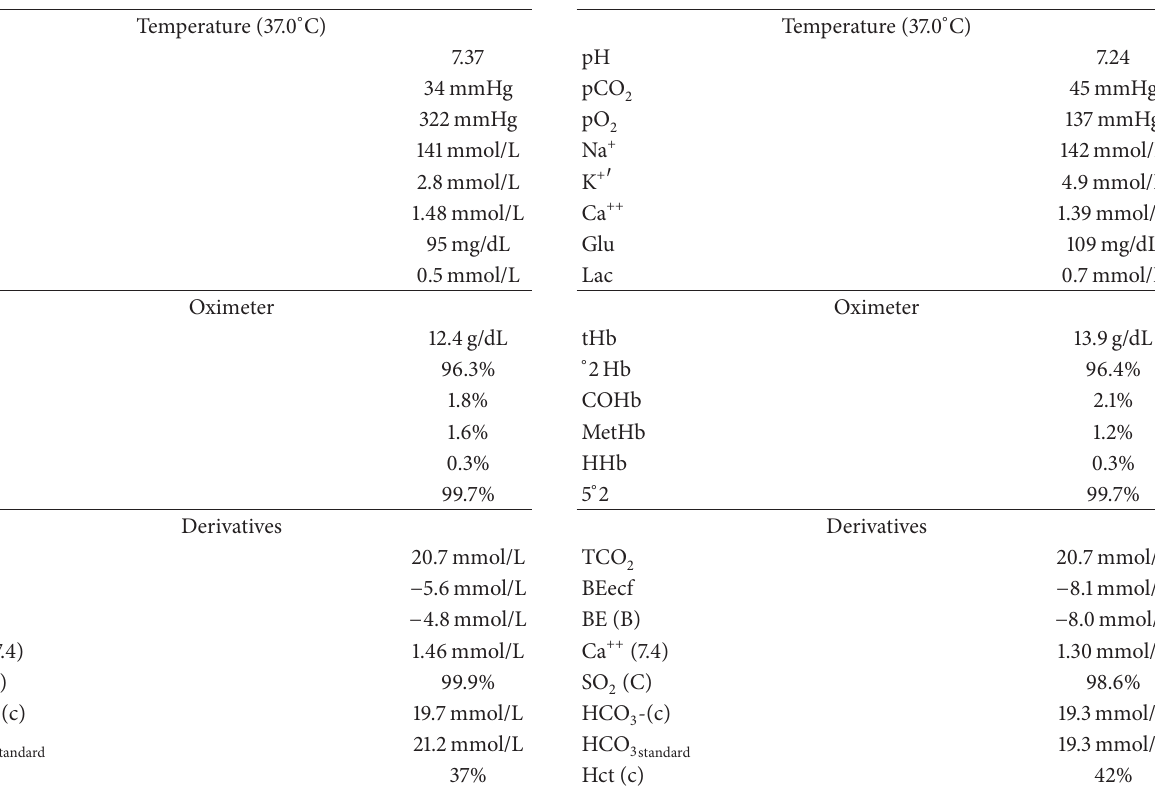
Table 1: Hemogasanalysis at the middle of the surgery. Table 2: Hemogasanalysis 1 hour after the end of